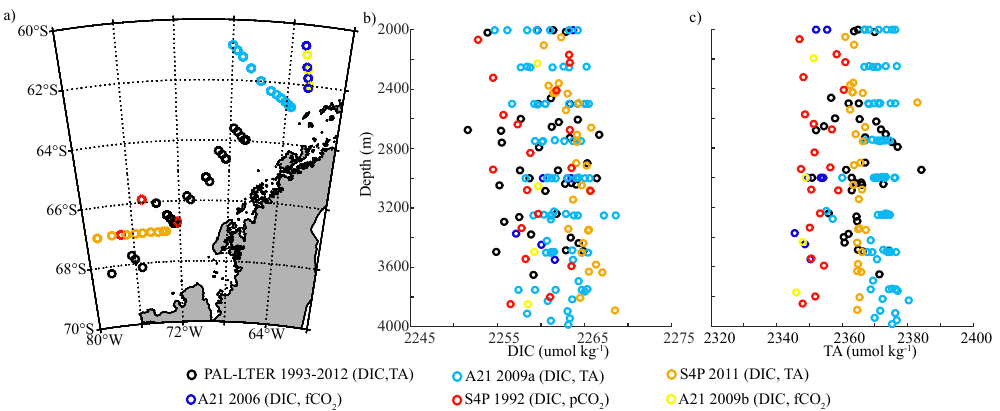
Figure 2. Comparison of deep-water (off-shelf) dissolved inorganic carbon (DIC, µmolkg − 1 ) and total alkalinity (TA, µmolkg − 1 ) data from Palmer Station Long Term Ecological Research (PAL-LTER) with other available cruise data. (a) Station locations and (b) DIC and (c) TA depth profiles from PAL-LTER cruises (1998–2012), World Ocean Circulation Experiment (WOCE) and Climate and Ocean – Variability, Predictability, and Change (CLIVAR) cruises along parts of sections A21 (2006, 2009) and S4P (1992, 2011). The directly measured parameters are listed in the parentheses and were used to calculate TA if not directly